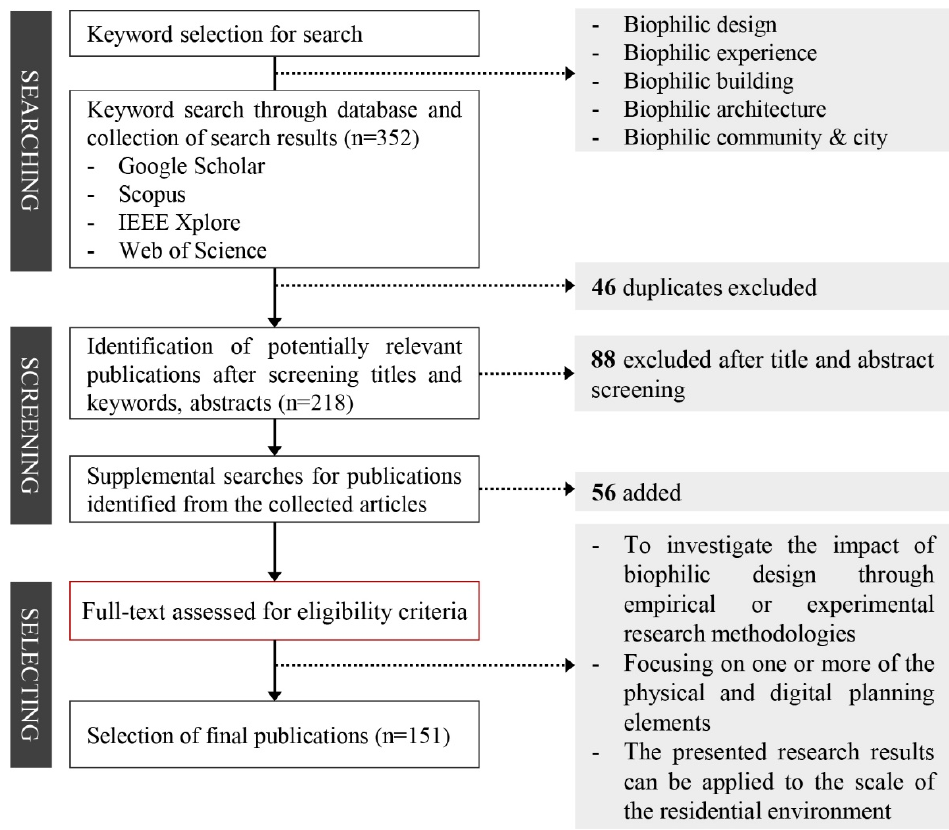
Figure 2. Method and scope of the literature review.